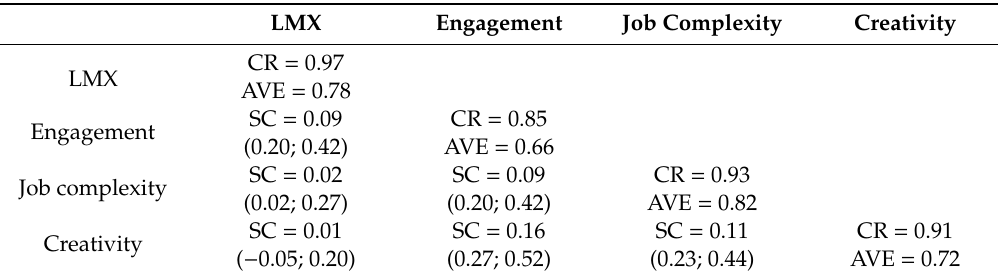
Table 2. Overall reliability and validity of the constructs.